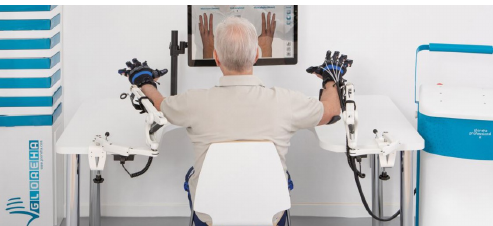
Figure 1. Gloreha Sinfonia (www.gloreha.com/sinfonia (accessed on 18 June 2020)).